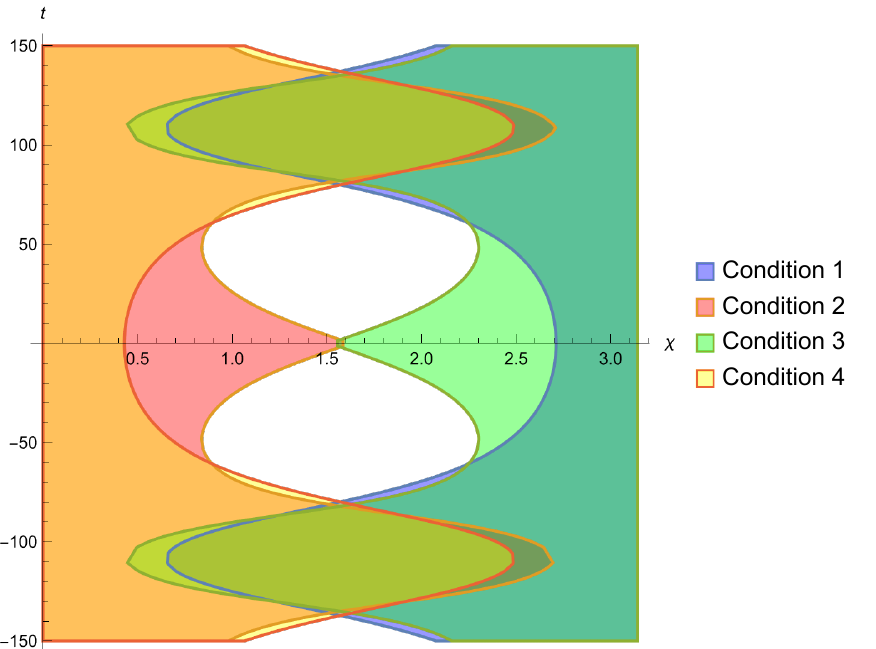
Figure 5 . Regions satisfying the four island conditions are shown for the simple harmonic universe, with ρ 0 = 0 . 01 , | Λ | = 0 . 0001 , T 0 = 1 . 6 × 10 − 5 . We choose to phrase the conditions here according to their original form in (3.2), (3.3), (3.4), (3.5) due to their nice symmetrical